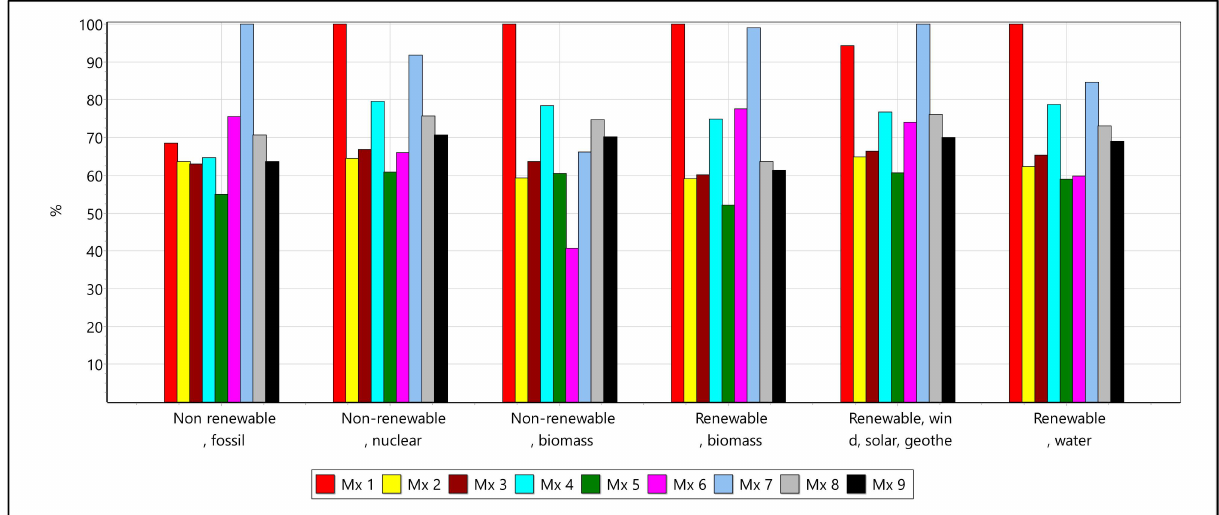
Figure 10. Energy Demand Analysis for different mineral sealing layer